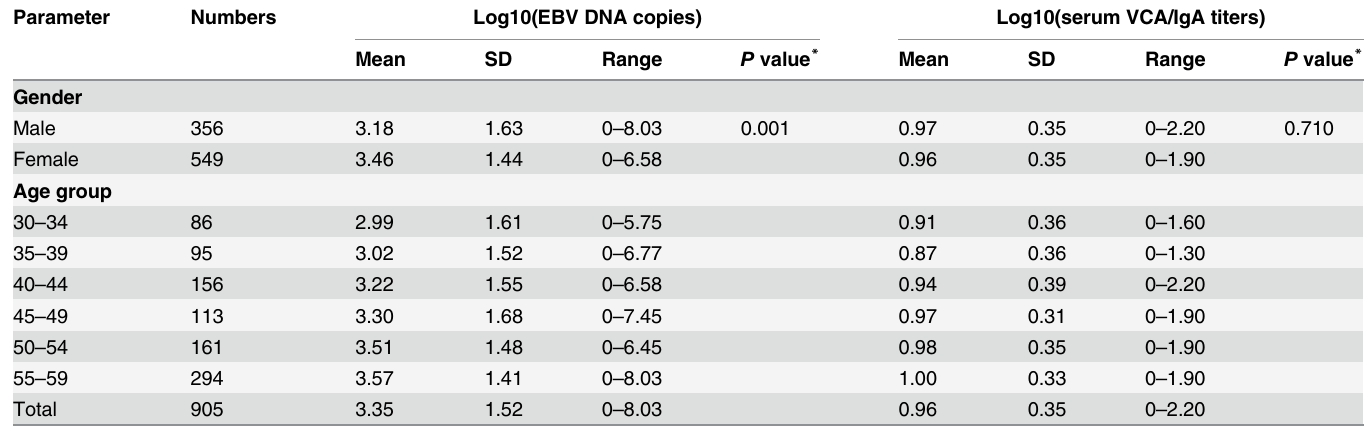
Table 4. Nasopharyngeal EBV DNA load and serum VCA/IgA titers by gender and age.